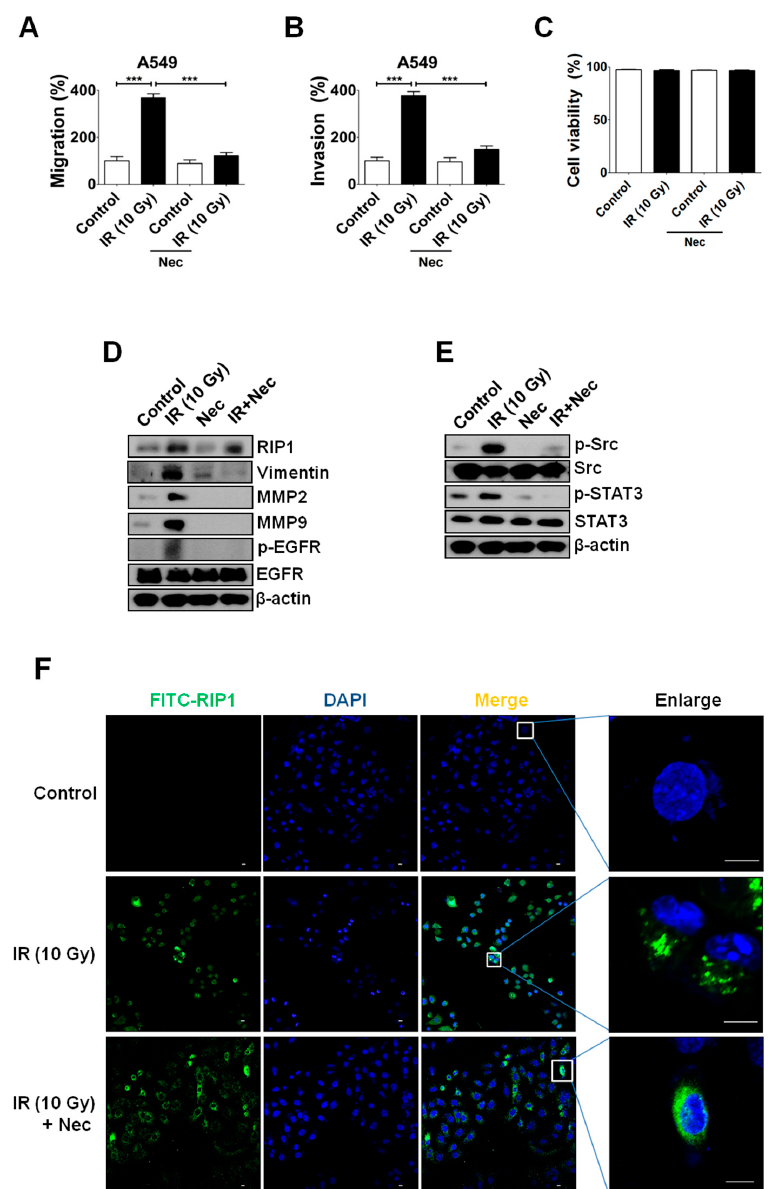
Figure 4. IR-mediated activation of EMT involves RIP1 kinase activity. ( A ) To determine the mechanism underlying IR-induced invasion of A549 cells, necrostatin was added to the lower chamber of a transwell system and cells were seeded onto the upper chamber. After 24 h, cells on the membrane were counted. (***; p < 0.001) ( B ) IR-induced migration of A549 cells. Experiments were performed as described in Materials and Methods. Representative data from triplicate experiments are shown on the right panel. (***; p < 0.001) ( C ) Cells were subjected to IR (10 Gy) and treated with necrostatin (20 μ m), and apoptotic cell death determined via the PI uptake assay. Representative data from triplicate experiments are shown. ( D , E ) Immunoblotting for RIP1, MMP-2, MMP-9 EGFR, p-EGFR, Src, p-Src, STAT3 p-STAT3, vimentin and β -actin (loading control). ( F ) Immunofluorescence staining of RIP1-positive A549 cells after treatment with IR. Endogenous RIP1 expression in IR-treated or non-treated A549 cells was determined via immunofluorescence staining. A549 cells were stained with DAPI to visualize nuclei (blue) and immunolabeled with an anti-RIP1 antibody, which was detected with FITC-conjugated IgG (green). Scale bar: 10 μ m.